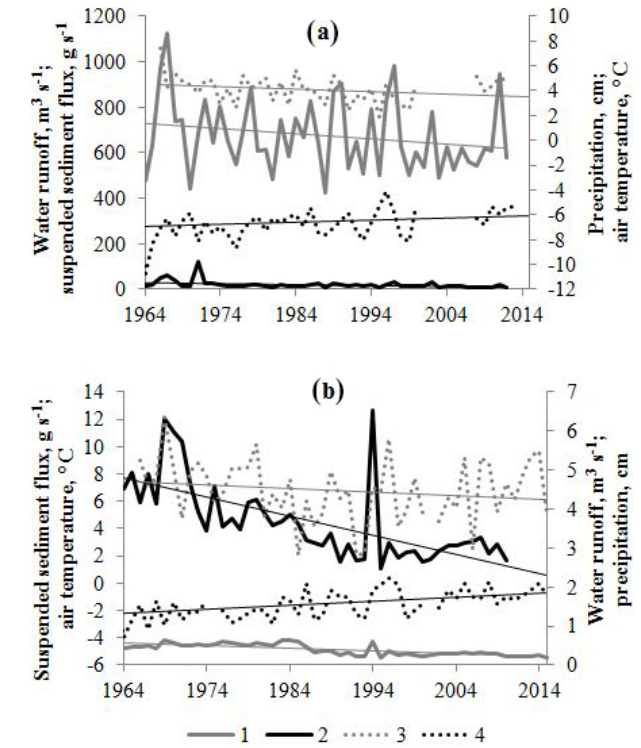
Figure 6. Correspondence of water runoff (1), suspended sedi- ment yield (2), precipitation (3) and air temperature (4) variabil- ity in the Penzhina River (Kamenskoe, a ) and the Dolinovka River (Dolinovka, b